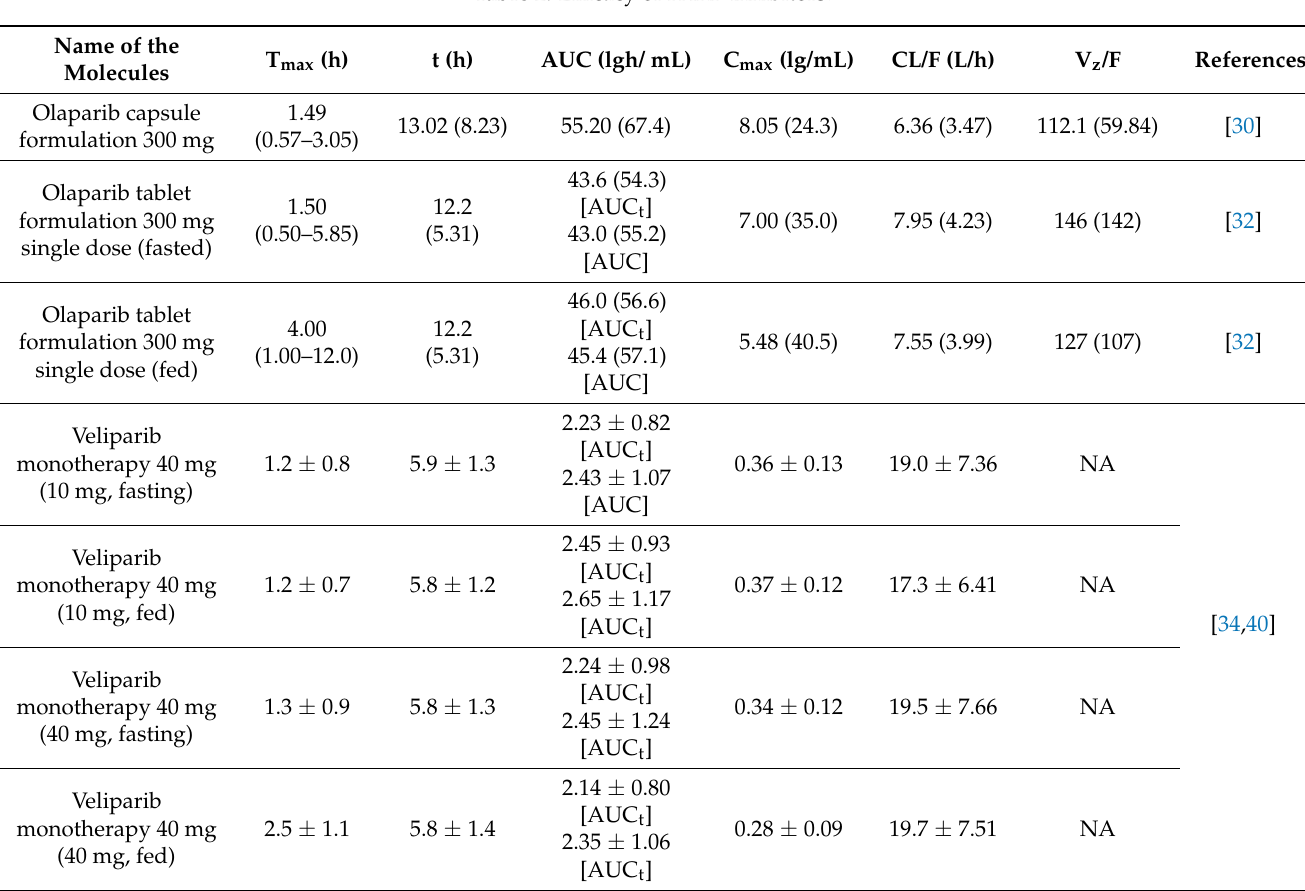
Table 2. Efficacy of PARP